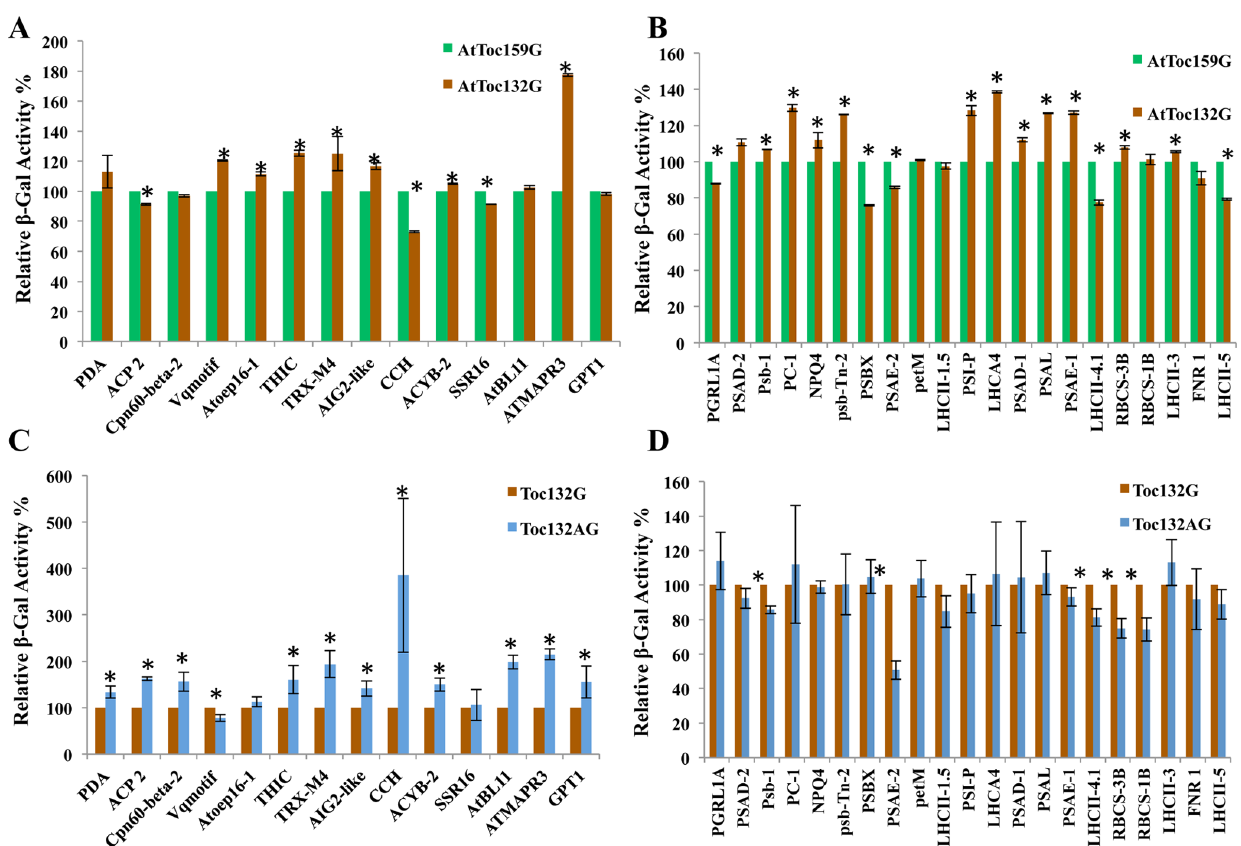
Figure 3. Comparative strengths of protein–protein interactions as determined by a quantitative b -galactosidase assay for prey proteins originally isolated from the cDNA library using the atToc159 G-domain as the bait. (A–D) Relative enzymatic activity of b -Gal in extracts from S. cerevisiae strain NMY51 that expressed atToc159G, atToc132G or atToc132AG bait and also carried NubG-Prey construct as indicated in Table 1 and 2. Yeast cells were grown to A 546 of , 0.8 in SD ( 2 Leu, 2 Trp) medium at 30 u C, followed by measurements as described in material and methods, and were quantified according to the following formula: Activity=1,000 6 OD 615 /V 6 t 6 OD 546 , were V is the volume of assay and t is the time of incubation, for b -Gal activity in cell extracts. The measured activity was normalised to that of mock co-transformed strains expressing atToc159G, atToc132G or atToc132AG baits and empty vector, pR3-N, for respective interactions. A relative b -Gal activity of 100% was arbitrarily assigned to the atToc159G bait containing (A–B) and atToc132G bait containing (C–D) pairwise interactions. The experiments were performed in triplicate and repeated at least twice. Error bars indicate 6 SD. Values marked with asterisks are significantly different (Student’s t-test; P # 0.05). (A) Interaction in yeast co-expressing atToc159G or atToc132G bait and non-photosynthetic prey interactors identified in atToc159G screening (Table 1). (B) Interaction in yeast co-expressing atToc159G or atToc132G bait and photosynthetic prey interactors identified in atToc159G screening (Table 2). (C) Interaction in yeast co-expressing atToc132G or atToc132AG bait and non-photosynthetic prey interactors identified in atToc159G screening (Table 1). (D) Interaction in yeast co-expressing atToc132G or atToc132AG bait and non-photosynthetic prey interactors identified in atToc159G screening (Table 2).